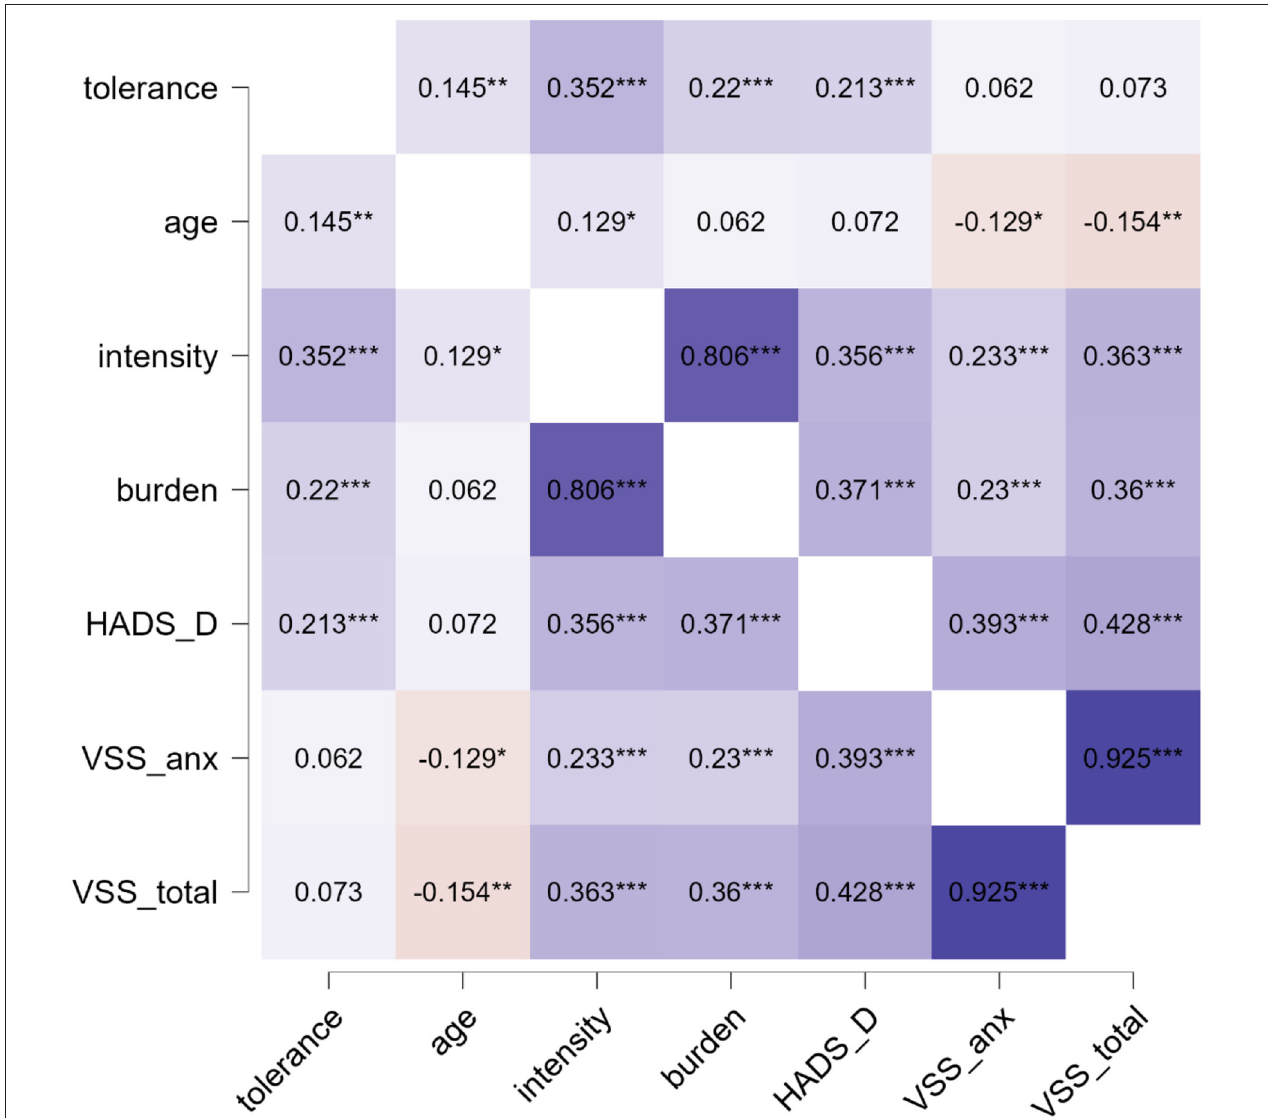
FIGURE 2 | Spearman’s rho heatmap. * p < 0.05, ** p < 0.01, *** p < 0.001. Blue indicates positive and red indicated negative correlation. HADS, hospital anxiety and depression scale; VSS_anx, vertigo severity scale autonomic-anxiety; VSS_total, total vertigo severity